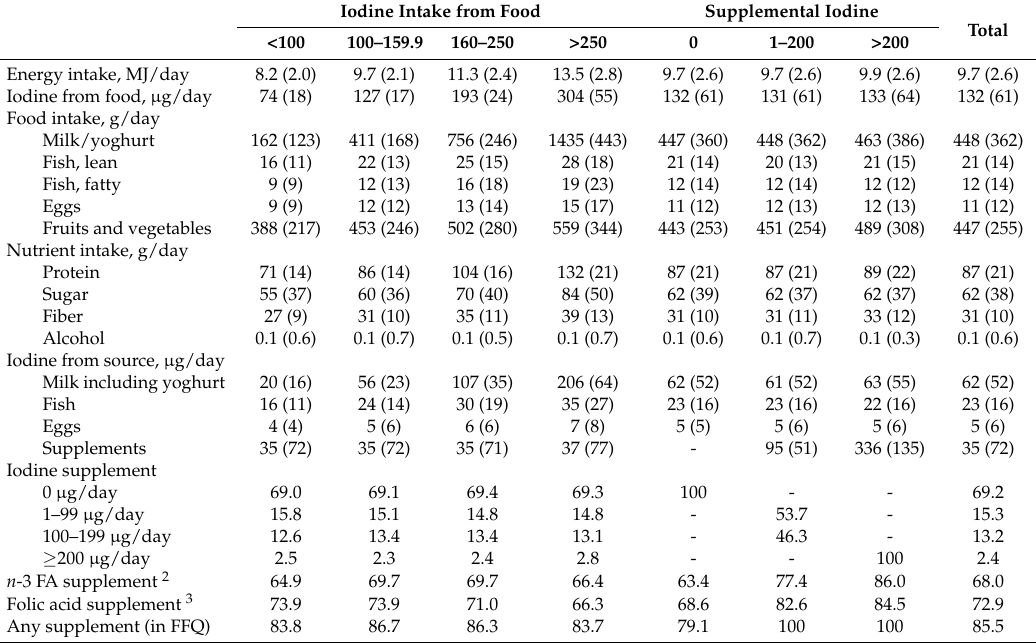
(in micrograms per day) during the first half of pregnancy 1 .